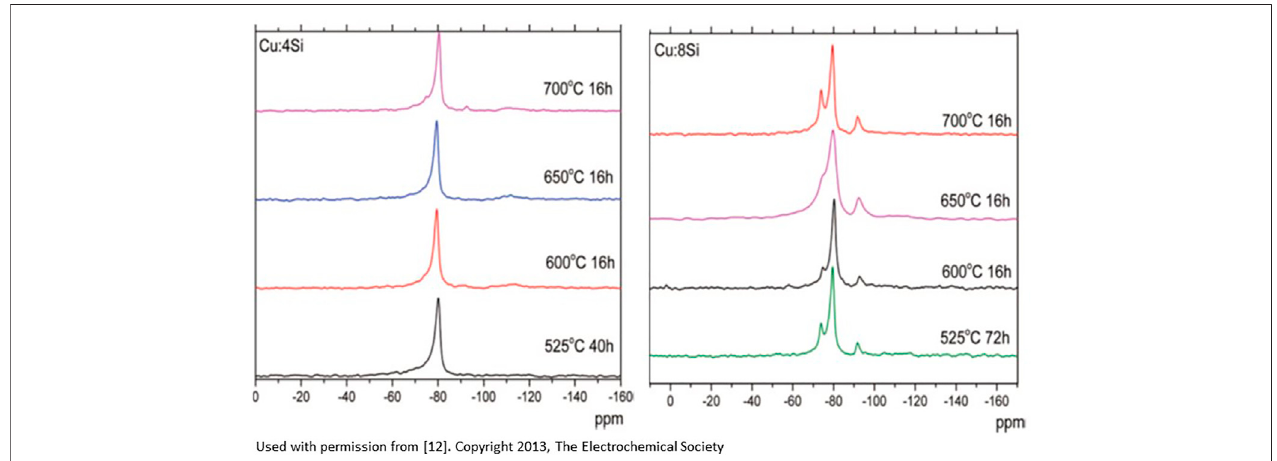
FIGURE 1 | 29 Si MAS NMR spectra on the effect of temperature treatment on the silicon local environment for Cu:4Si composition (left), and Cu:8Si composition (right). The extra peaks in the Cu:8Si are most likely due to the silicon within the copper-silicon matrix, interfacial silicon atoms, or silicon hydrides [From reference 12].